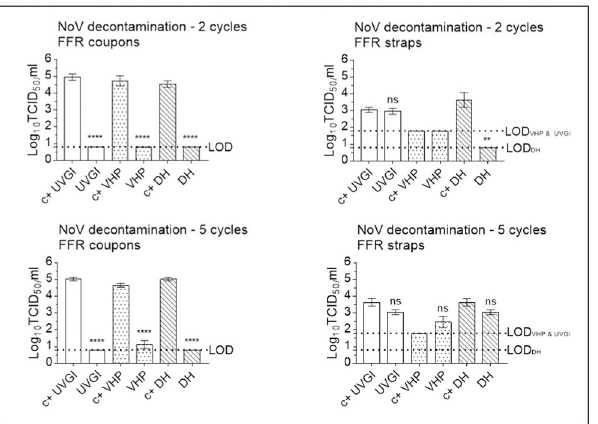
Fig 10. Murine norovirus (MuNoV) inactivation following multiple cycle filtering facepiece respirator (FFR) decontamination using dry heat (DH), vaporised hydrogen peroxide (VHP), and ultraviolet germicidal irradiation (UVGI). Titrations were performed after two or five (three in the case of DH) decontamination treatments on MuNoV- inoculated FFR coupons and straps. MuNoV infectivity was analysed in RAW264.7 cells. The cell culture limit of detection (LOD) was 0.80 log10 TCID 50 /mL (6.31 × 10 0 TCID 50 /mL) for all analyses except those concerning VHP- and UVGI-treated FFR straps (1.80 log10 TCID 50 /mL (6.31 × 10 1 TCID 50 /mL)). Per decontamination method, nine PRCV-inoculated, decontaminated coupons (n = 9) and three inoculated, decontaminated straps (n = 3) were analysed in parallel to inoculated, untreated, positive control (c+) coupons (n = 9) and straps (n = 3). Mean log10 TCID 50 /mL and standard errors of the means are represented. P-values were computed by using a two-sided independent sample t-test, where ���� P < 0.0001, ��� P < 0.001, �� P < 0.01, � P < 0.05, and ns is P � 0.05.